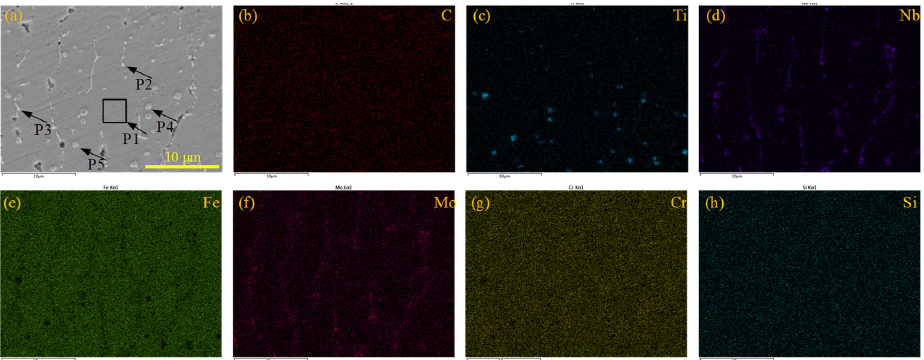
Figure 4. ( a ) SEM image, and ( b – h ) mapping of C, Ti, Nb, Fe, Mo, Cr, and Si elements of the composite coating. Table 3. EDS results for each region in Figure 4 (at.%).